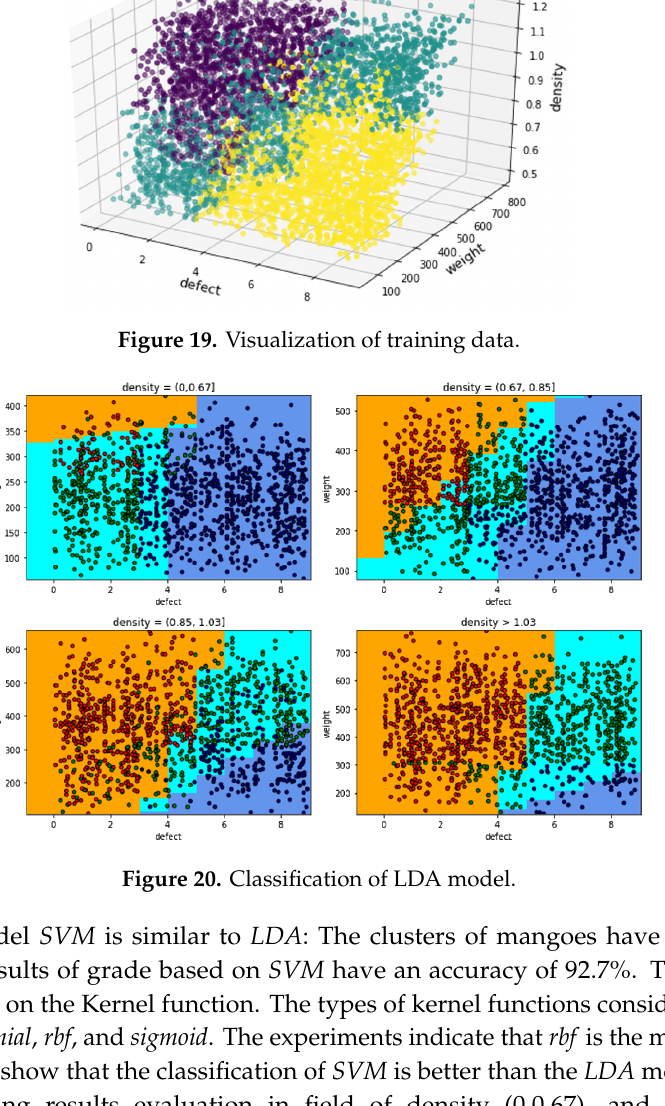
Figure 19. Visualization of training data.